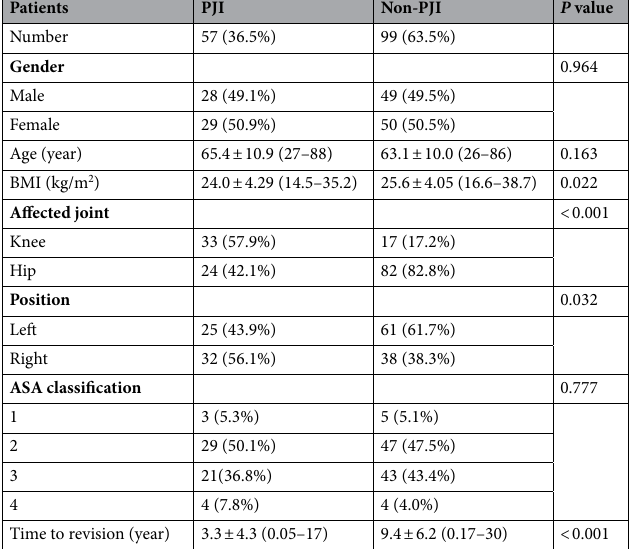
Table 2. Basic characteristics of patients in the study.